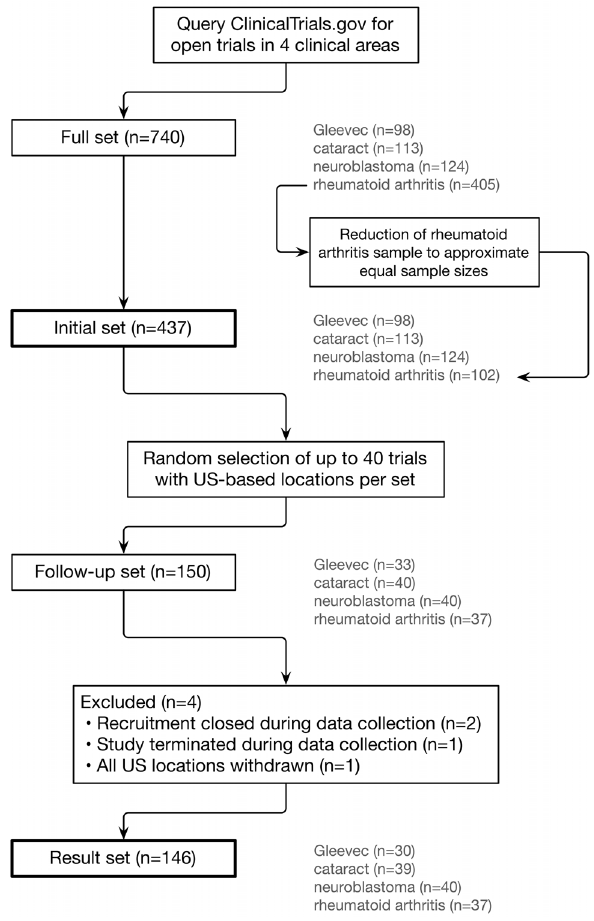
Figure 1. Trial selection workflow.